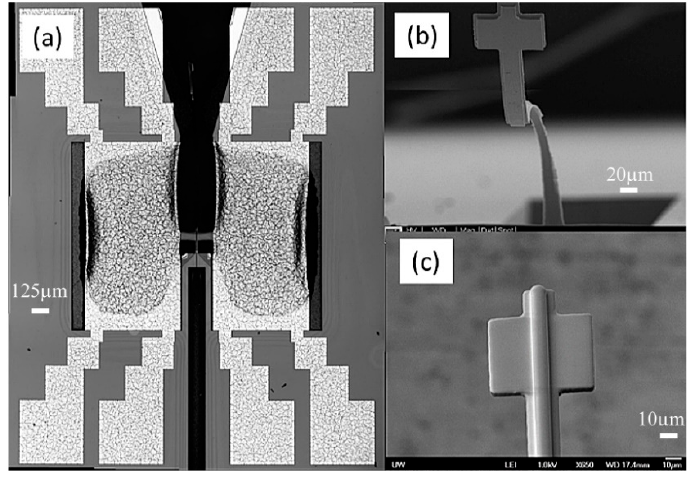
Figure 15. ( a ) MEMS scanner with push ‐ pull actuators. ( b ) Bending waveguide due to large aspect ratio and residual stress. ( c ) SU ‐ 8 rib waveguide at the tip.